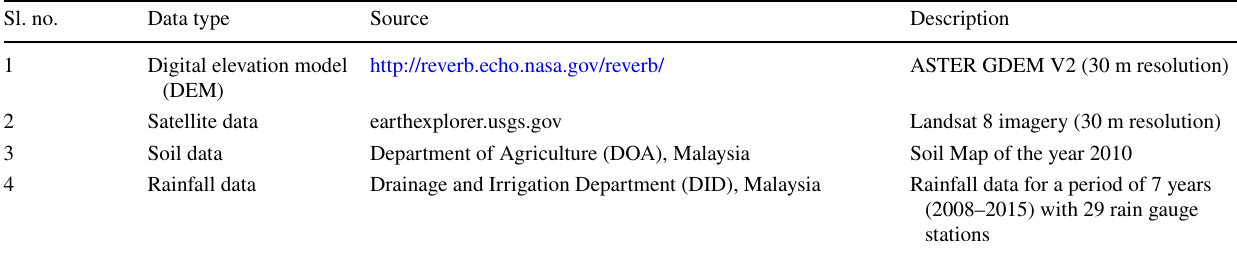
Table 1 Description of the data Sl.